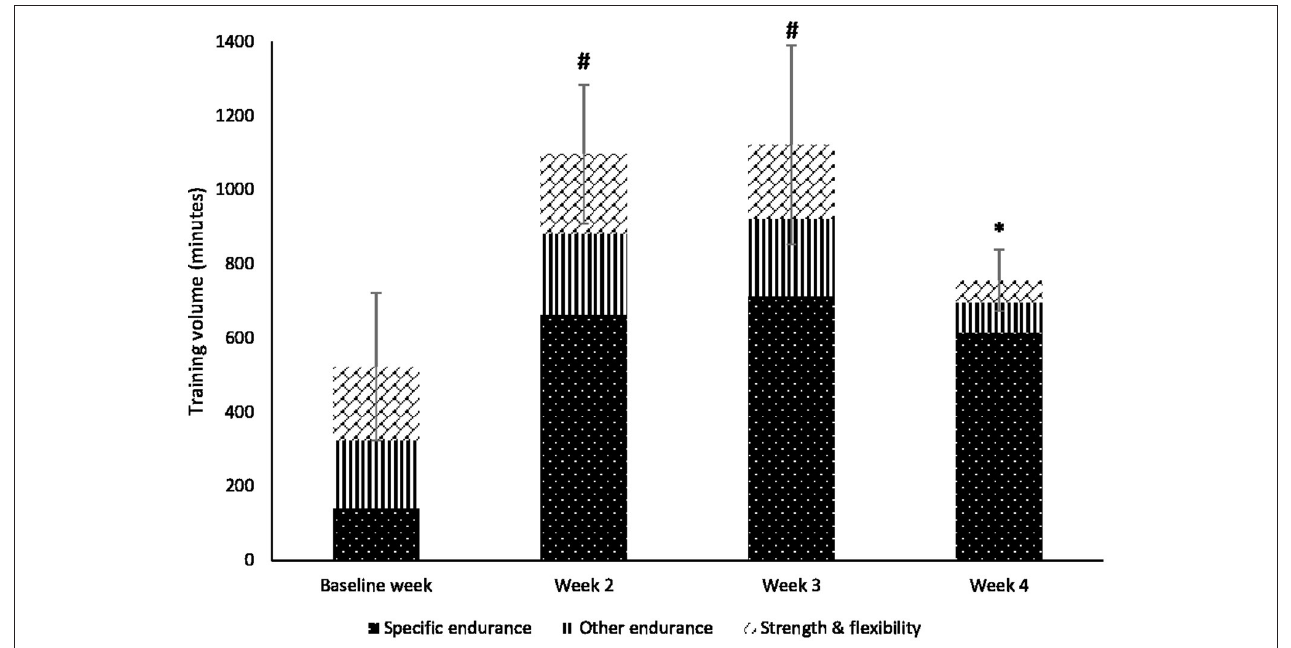
FIGURE 1 | Total training volume (minutes) and the volumes of each training type during the 4-week training period. Specific endurance includes indoor rowing (ergometer) and outdoor rowing. Other endurance includes all types of other endurance sports—mostly running and cycling; * Significantly different total training volumes from baseline week ( p < 0.05); #Significantly different total training volumes from baseline week to week 4 ( p < 0.05).